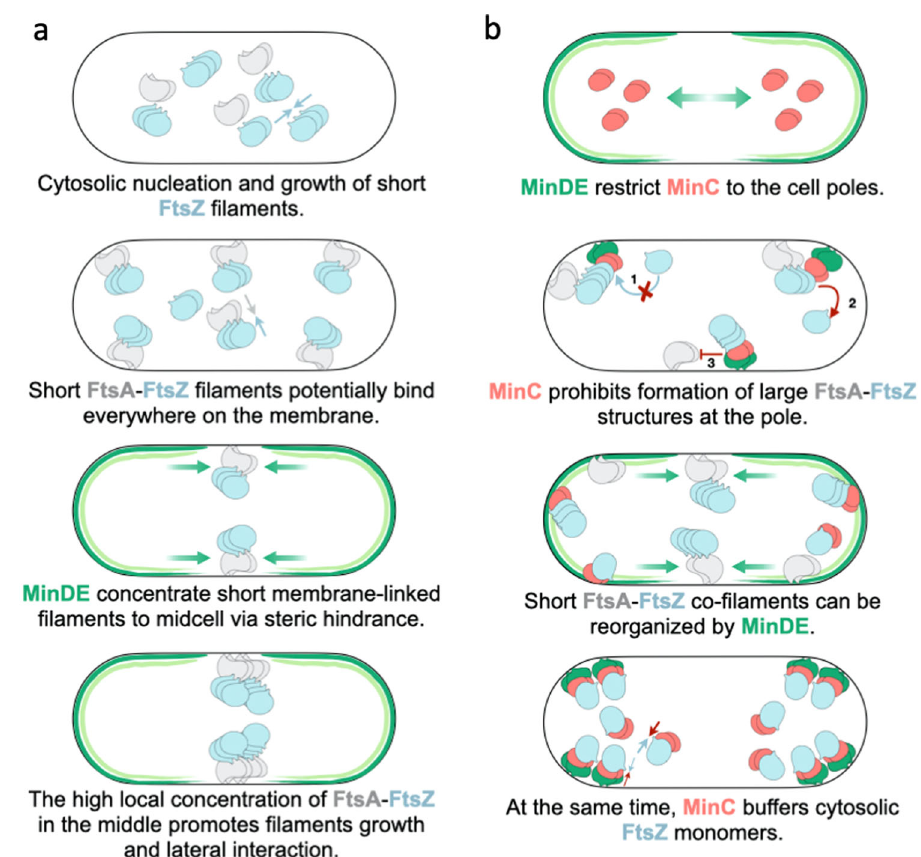
Fig. 5 Model for the patterning of bacterial cytokinesis components by MinDE oscillations in E. coli . a Short proto fi laments of FtsA-FtsZ nucleate and grow in the cytosol. The short FtsZ-FtsA (and possibly ZipA-FtsZ) fi laments bind at random locations along the membrane. MinDE propagating diffusion barrier concentrates the short fi laments at midcell. The high local concentration of short fi laments in the middle promotes lateral interaction, bundling and extension of fi laments, and subsequent proto-ring formation. b MinD-MinE dynamics generate a concentration maximum of MinC at the poles, where the formation of extended FtsA-FtsZ structures that could not be displaced by MinDE only is prohibited by the following processes: MinCD inhibits long FtsA- FtsZ structures by capping growing FtsZ polymers (1), by depolymerizing FtsZ structures (2), and by competing with other membrane proteins for binding to FtsZ (3). The short co- fi laments have a reduced lifetime at the membrane and can more easily be outcompeted by MinDE at the division site. Furthermore, MinC is responsible for sequestering FtsZ monomers through direct interaction, keeping the cytosolic concentration of FtsZ lower than the threshold to form long fi laments and bundles. The interaction between membrane-bound MinD and MinC boosts the local concentration of MinC, which might operate as a mechanism to accentuate the depletion of FtsZ subunits. Together, the processes described in ( a ) and ( b ) restrict proto-ring formation to